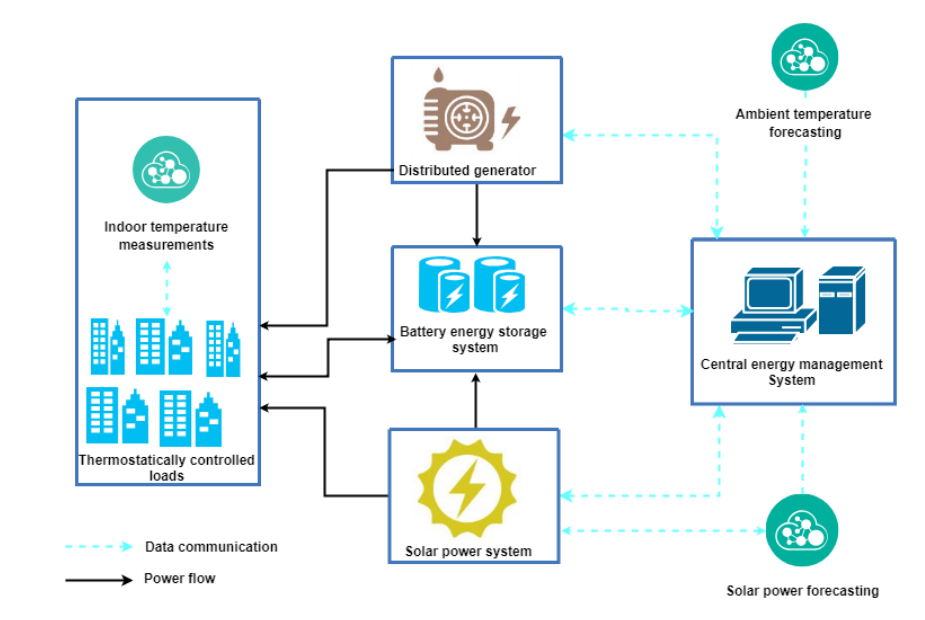
Figure 1. Configuration of the